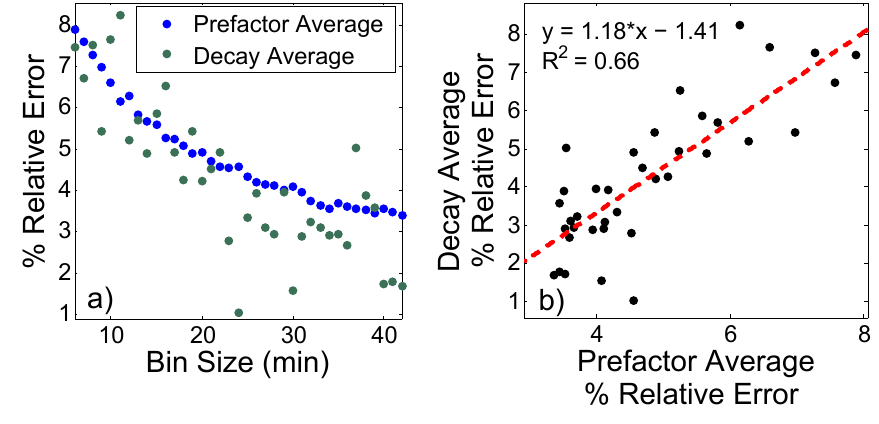
Fig. 5. Comparison between the two methods of averaging: prefactor averaging, where the decays of shortest integration are fit followed by averaging the prefactors to desired time resolution, and decay averaging, where the decay is averaged over desired period of integration followed by fitting. (a) The percent relative errors for the two averaging methods versus the averaging bin size. (b) The correlation between the relative errors in the two averaging methods with the accompanying trend line and